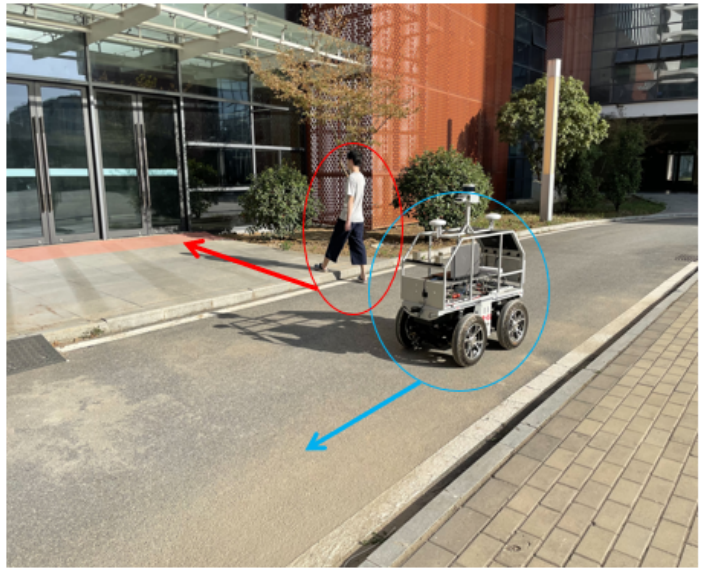
Figure 21. The stage after the vehicle actively avoids pedestrians. As shown in Figure 22, it shows the dynamic obstacle avoidance capability in other scenarios in the